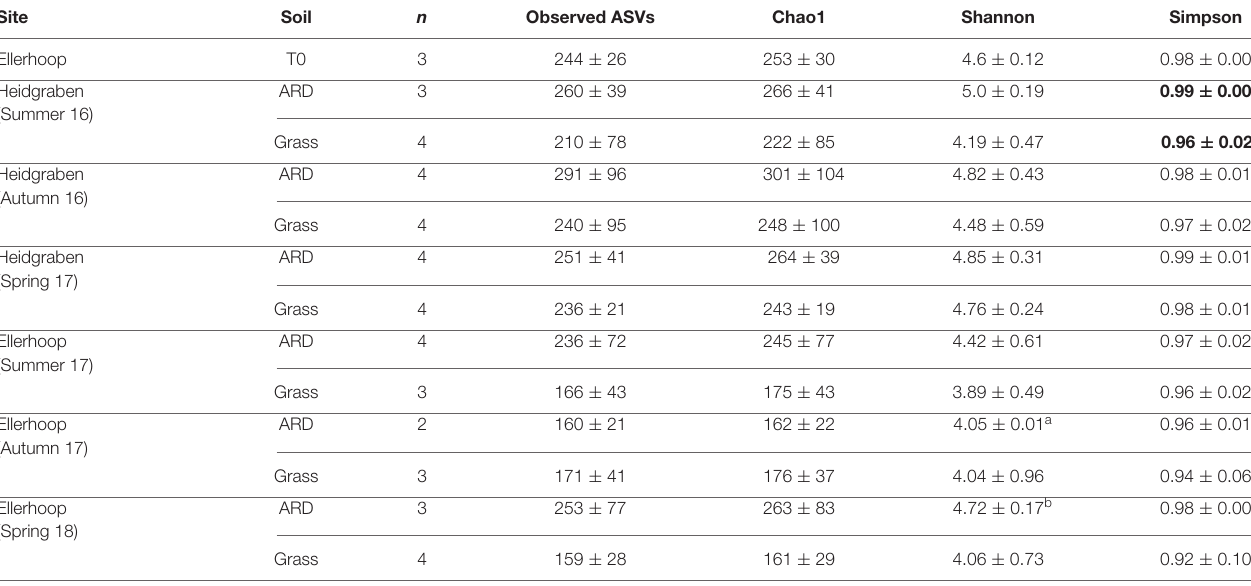
TABLE 2 | Richness and diversity of endophytic bacterial communities based on amplicon sequence variants (ASVs) in roots from Bittenfelder plants grown in apple replant disease (ARD) plots or grass plots at the sites Heidgraben and Ellerhoop. Site Soil n Observed ASVs Chao1 Shannon Simpson